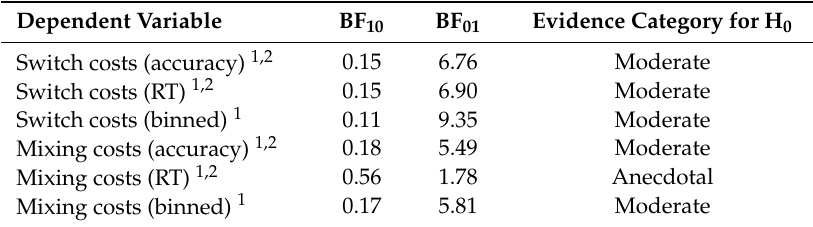
Table 3. Summary of interaction e ff ects of Gratitude and Switching / Mixing on accuracy and reaction time using Bayesian